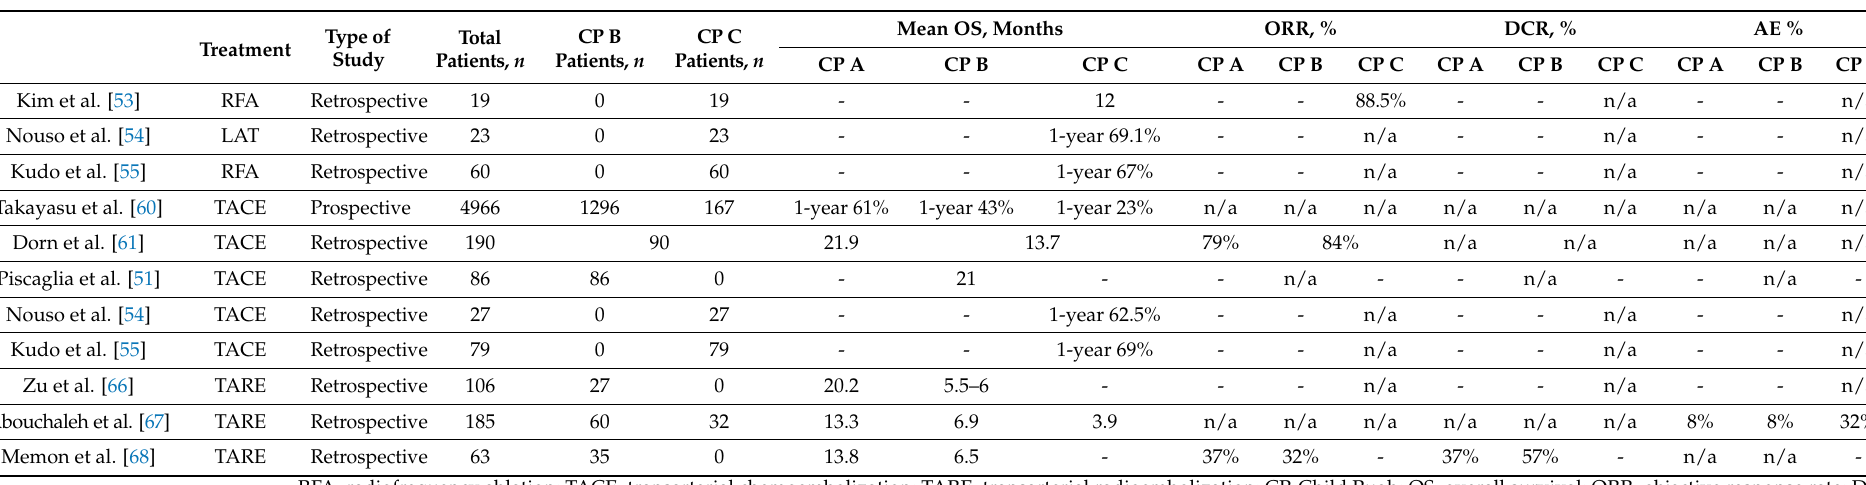
Table 3. Studies examining the efficacy and safety of locoregional treatments in patients with decompensated cirrhosis and hepatocellular